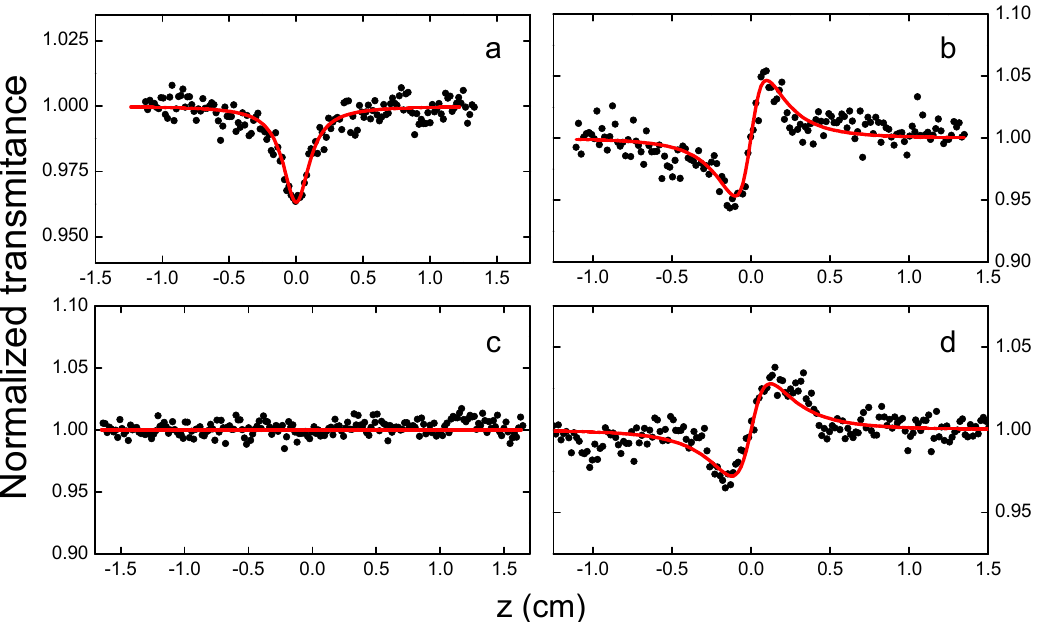
Figure 1. Open- and closed-aperture Z-scan signatures and their corresponding fitting curves at 1.77 eV (700 nm) ( a and b , respectively) and at 0.88 eV (1400 nm) ( c and d , respectively).